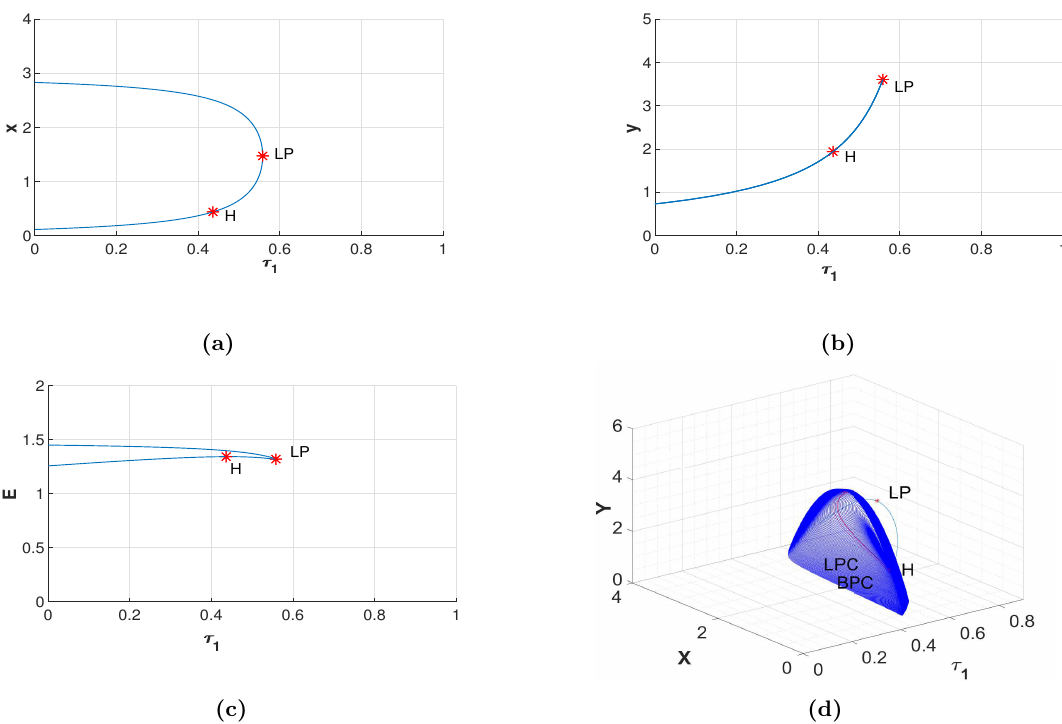
Figure 3. (a) Different steady state behavior of prey for the effect of τ 1 . (b) Different steady state behavior of predator for the effect of τ 1 . (c) Different steady state behavior of harvesting effort for the effect of τ 1 . (d) The family of limit cycles bifurcating from the Hopf point H for τ 1